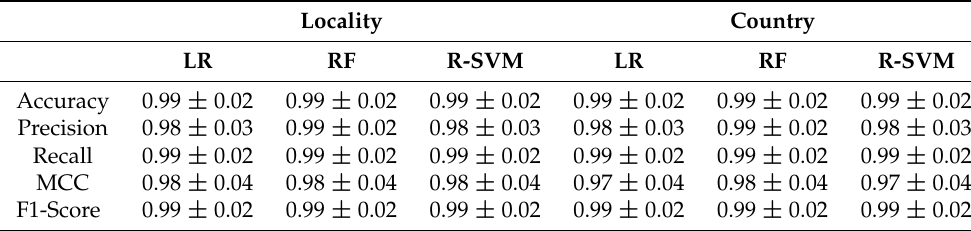
Table 6. Student’s geographic feature identification performance